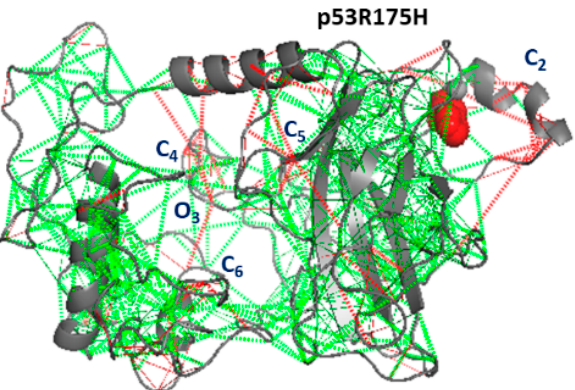
Figure 8. Frustration analysis of p53R175H. The level of frustration is represented by the colored scale: green represents minimal frustration and red high frustration. The mutated residue (175H, red) and the Zn ion (grey) are represented as spheres.